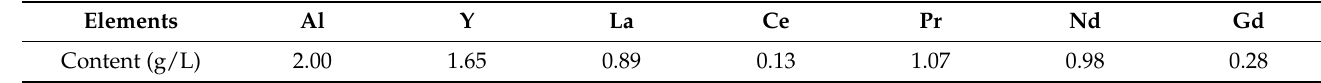
Table 1. Typical chemical analysis of